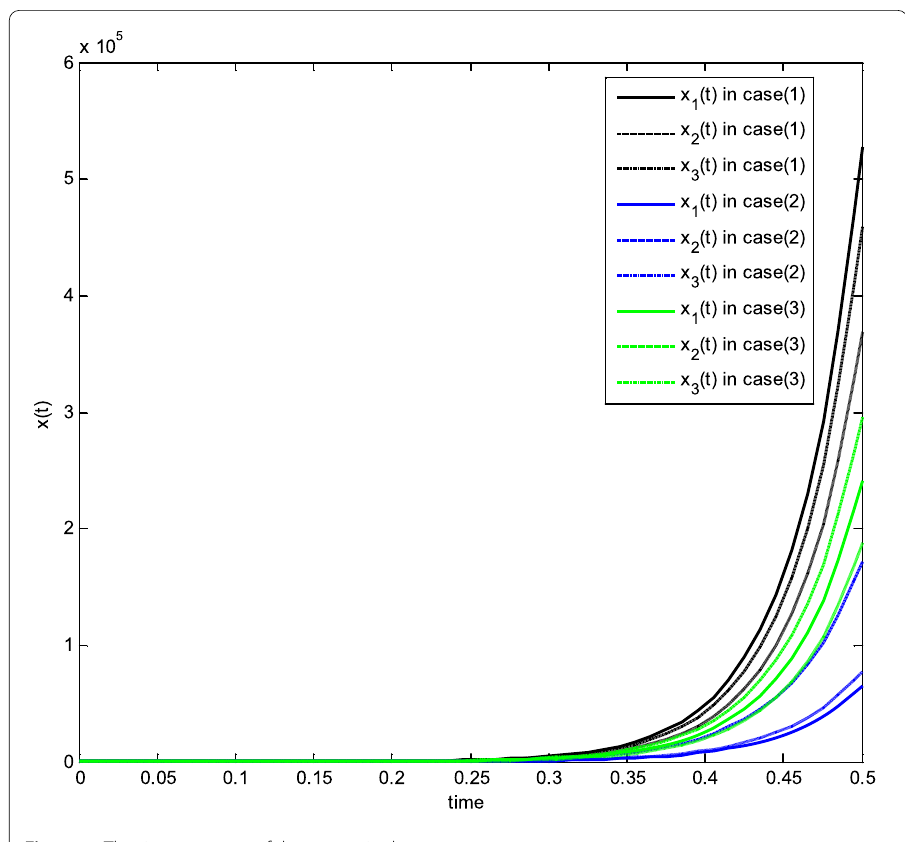
Figure 4 The time response of the system in three